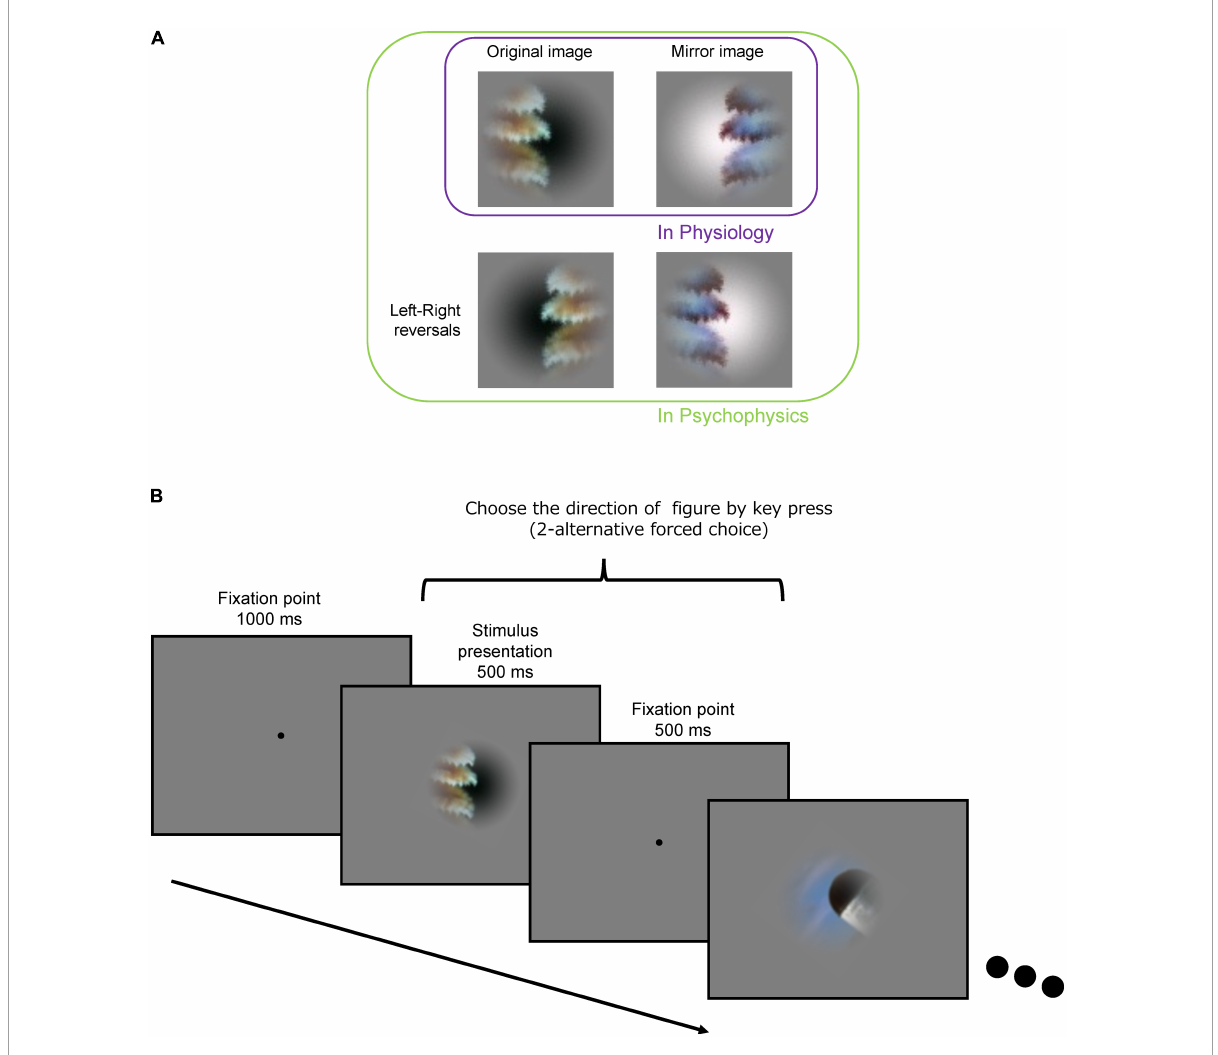
FIGURE2 Procedure for the psychophysical experiment. (A) Original (top-left), mirror image (top-right), and its left-right reversals (bottom-left and bottom-right) of an example stimulus. (B) Following an initial fixation period of 1,000 ms, a stimulus presentation period (500 ms) and a fixation period (500 ms) were repeated. Subjects were asked to indicate the DoF with the left and right arrow keys during the stimulus presentation and fixation